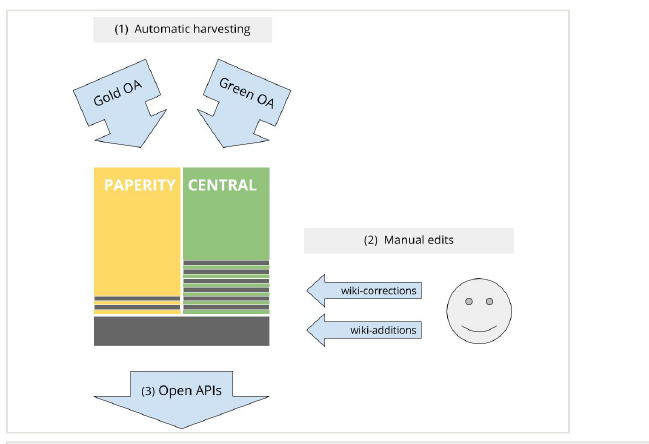
Figure 2. Paperity Central will combine (1) automatic harvesting of "gold" and "green" OA literature with (2) manual wiki-edits by users: corrections/extensions to existing entries (grey stripes) or additions of new entries (grey box). Manual edits are more important for "green" than "gold" data, because of lower quality of "green" metadata as pulled from repositories, compared to "gold" data pulled from original sources (publisher websites). Paperity Central will also expose all the collected data to external applications through open APIs